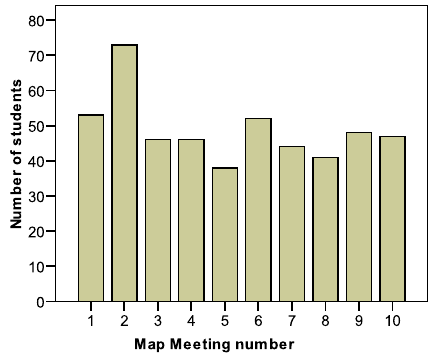
FIG. 5. (cid:1) Color online (cid:2) Weekly attendance at map meetings.